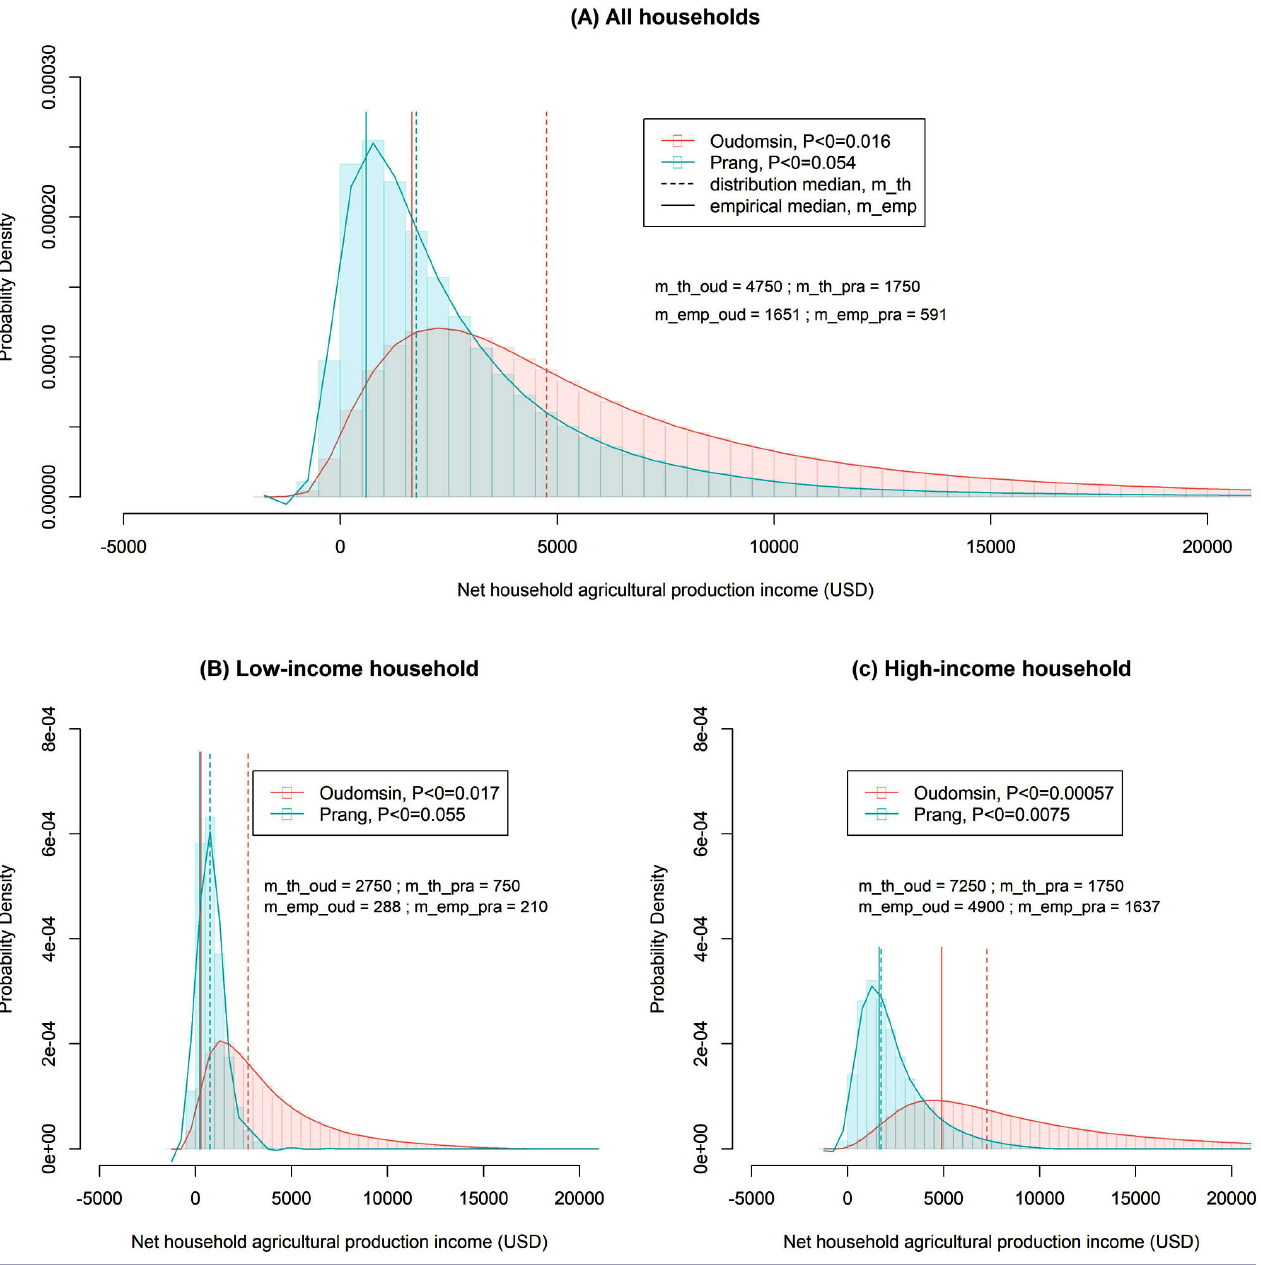
of the total income for cardamom-cultivating households in Prang (Table A1.1). The proportionally large impact of rubber production on the theoretical distribution of agricultural production income stems from the large variability in historical rubber prices and the wide range in household rubber hectares,